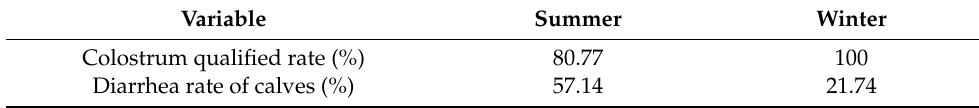
Table 3. Qualified rate of colostrum and diarrhea rate of calves during one week after delivery.